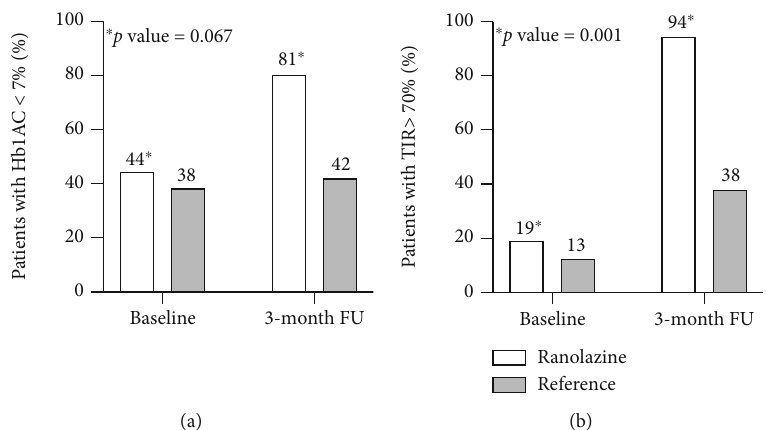
Figure 1: Ranolazine e ff ect on Hb1Ac and short-term GV. (a) Patients with Hb1Ac < 7 % at baseline and 3 months in the two groups; (b) Patients with TIR > 70 % at baseline and 3 months in the two groups. Hb1Ac: haemoglobin 1Ac; TIR: time in range. Table 3: Flow-mediated dilation and oxidative stress at baseline and after 3-month follow-up. Ranolazine No